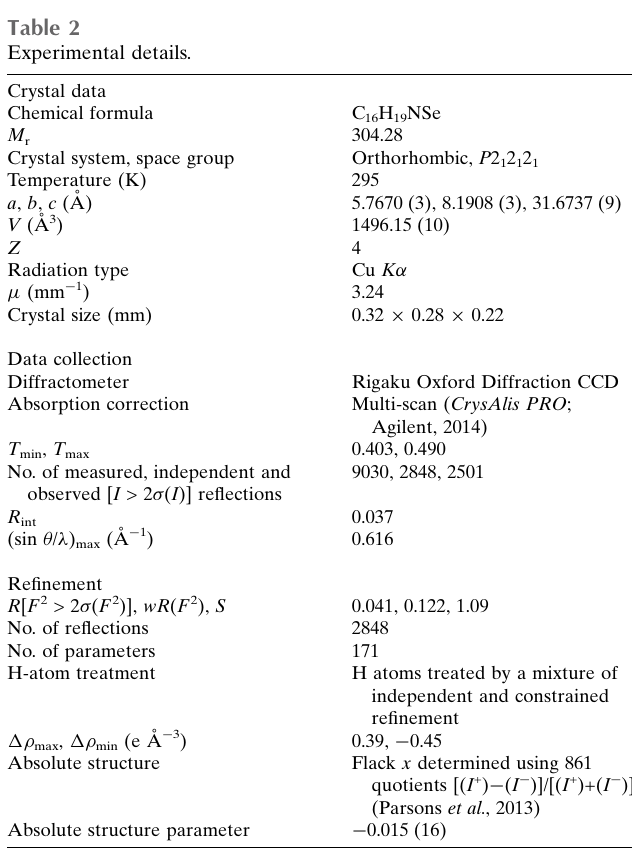
Table 2 Experimental details.